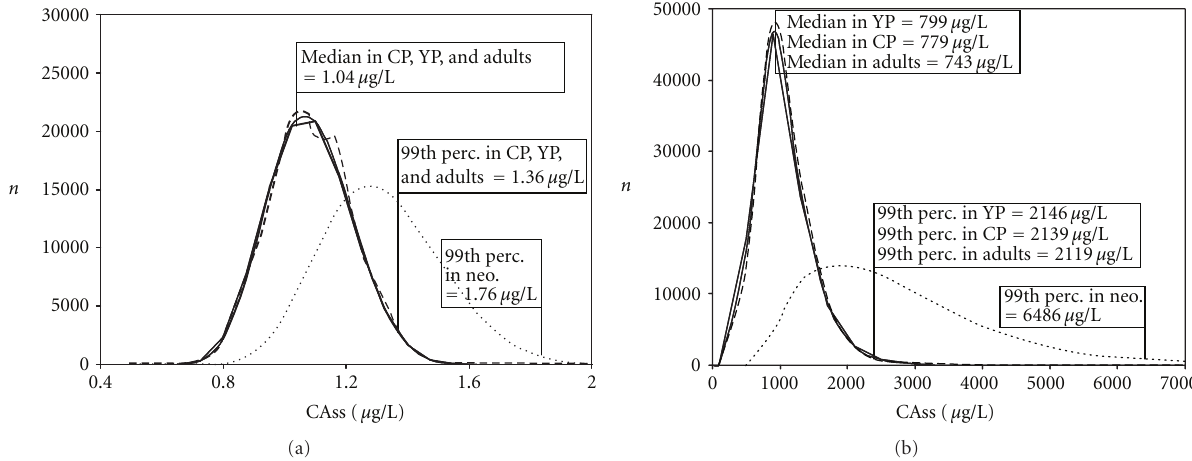
Figure 3: Distribution of individual values obtained for CAss for constant inhalation exposure to benzene (a) and 1,4-dioxane (b) in the entire Canadian (CP, thick — ) and “younger” (YP, –– ) populations of 100,000 people, in 100,000 adults (—) and in 100,000 of the most susceptible neonates (neo, ... ). Median and 99th percentile values only (for clarity reasons) are indicated.